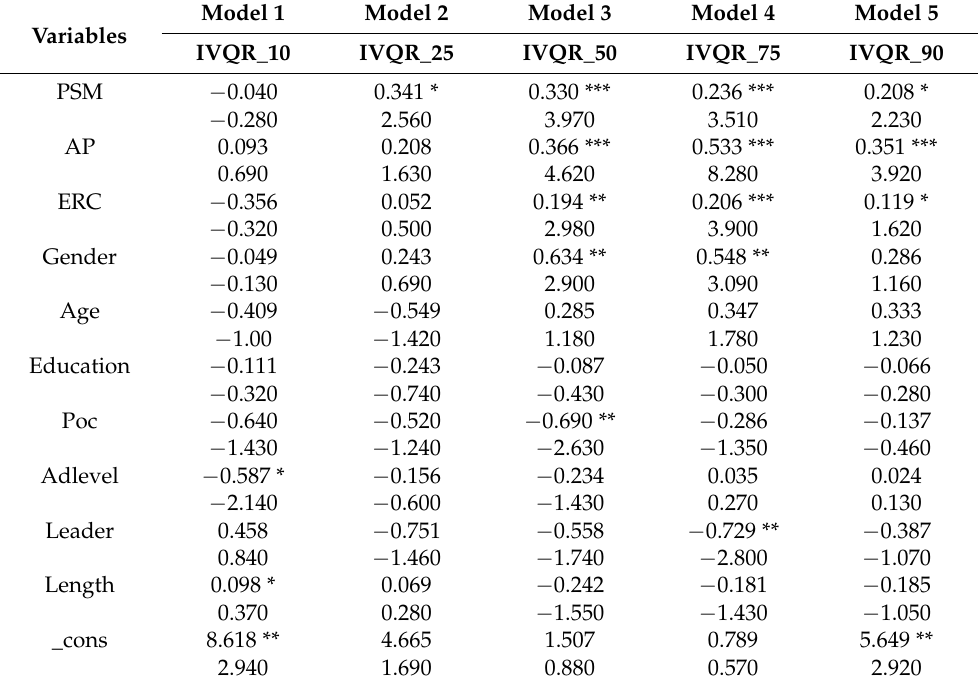
Table 5. The quantile regression model ( n = 1293).